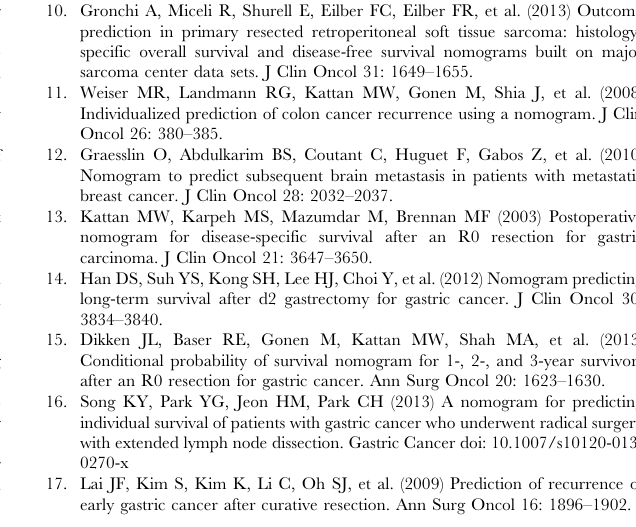
Table S1 Comparison of patient clinicopathologic char- acteristics in the Chinese and MSKCC cohort.